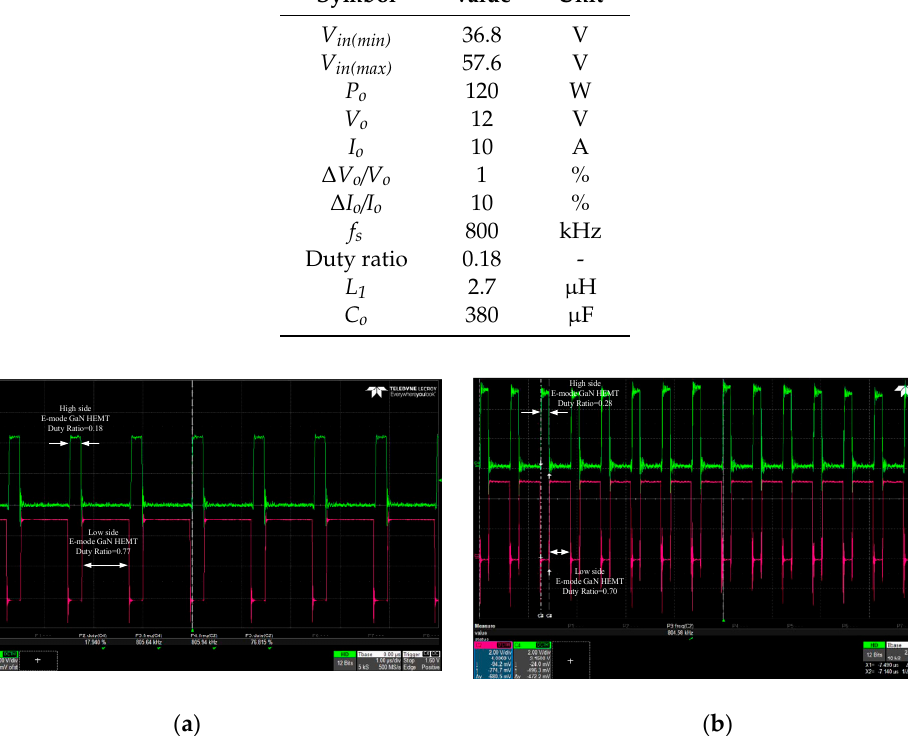
Figure 10. PWM signals of E-mode GaN HEMT. ( a ) No-load, 2 V/div, time: 1 μ s/div. ( b ) Full-load, 2 V/div, time: 1 μ s/div.